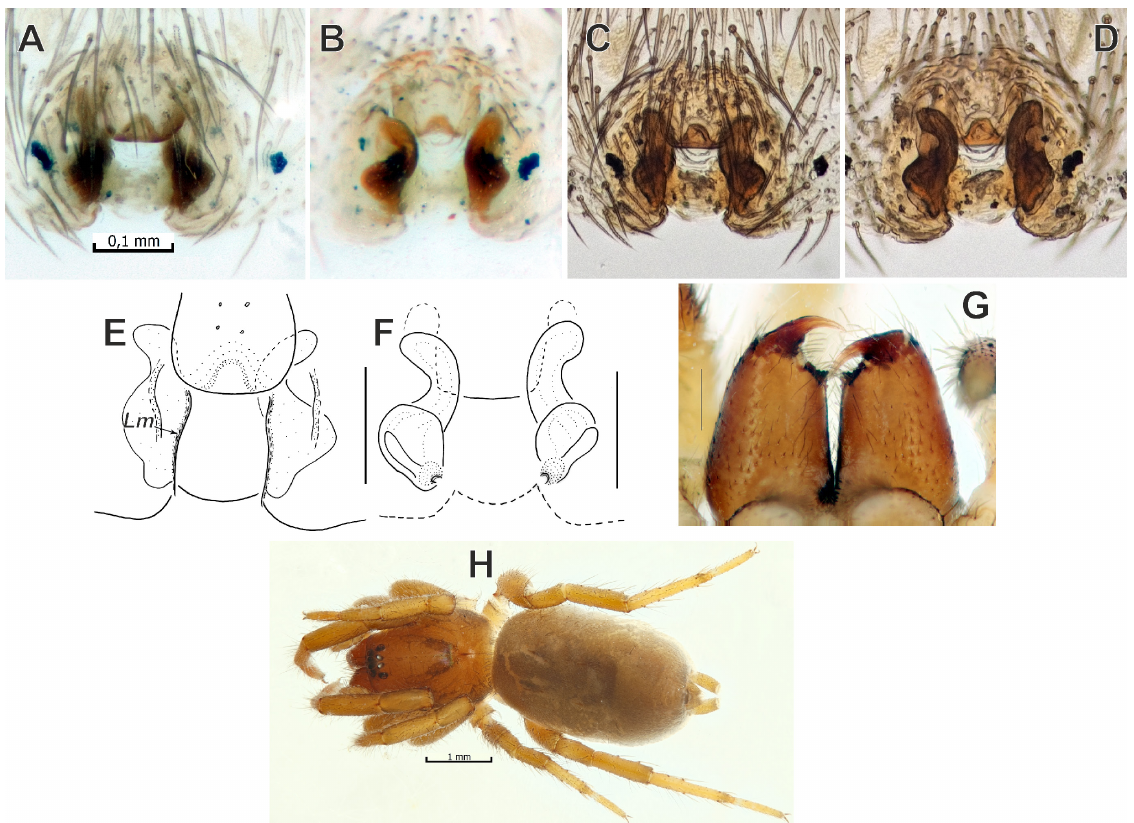
Fig. 10. Gnaphosa qamsarica sp. nov., holotype, ♀ (MHNG). A, C, E . Epigyne, ventral view. B, D, F . Epigyne, dorsal view. G . Chelicerae, posterior view. H . Habitus, dorsal view. Abbreviation: Lm = lateral margin. Scale bars: 0.1 mm, unless stated